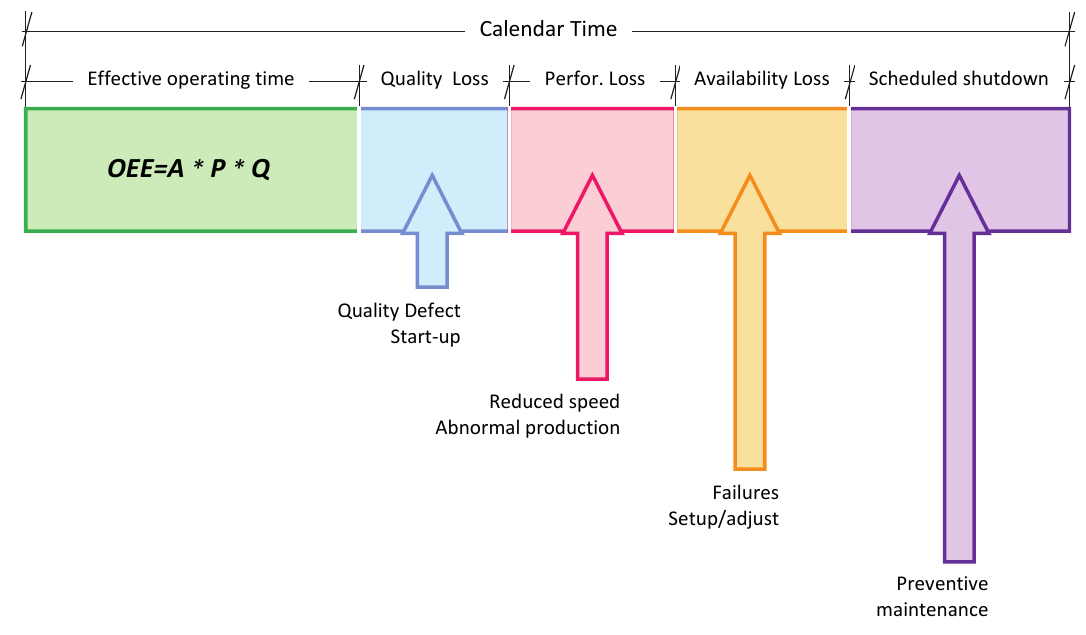
Fig. 1. OEE Timeline. Source: Muñoz-Villamizar et al., (2018). OEE definition. Source: Jonsson and Lesshammar